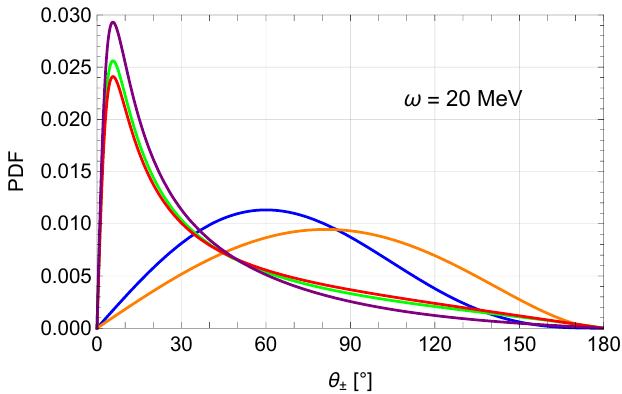
Figure 8 . Normalized angular correlation distributions of the e + e − pair from the various multipole contribution to the IPC process: L 0 (blue), L 1 (orange), E 1 (green), E 1 + L 1 (red), M 1